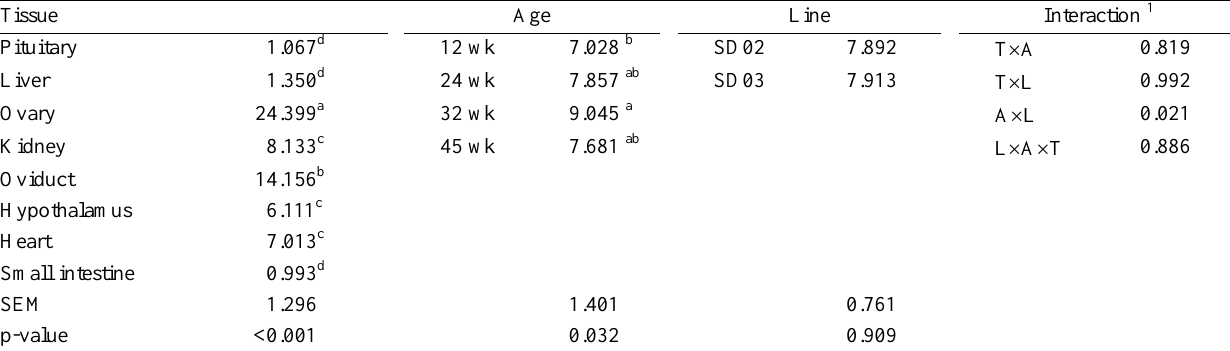
Table 2. Main effects and interactions of tissue, age and line on chicken CRBP II mRNA abundance Tissue Age Line